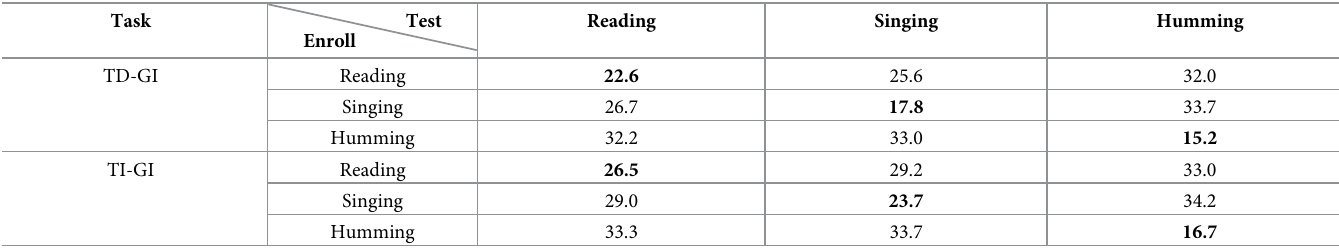
Table 9. EER% on the x-vector based cross-speaking ASV tasks, using the whole RSH to train the x-vector extractor. Task Test Reading Singing Enroll TD-GI Reading